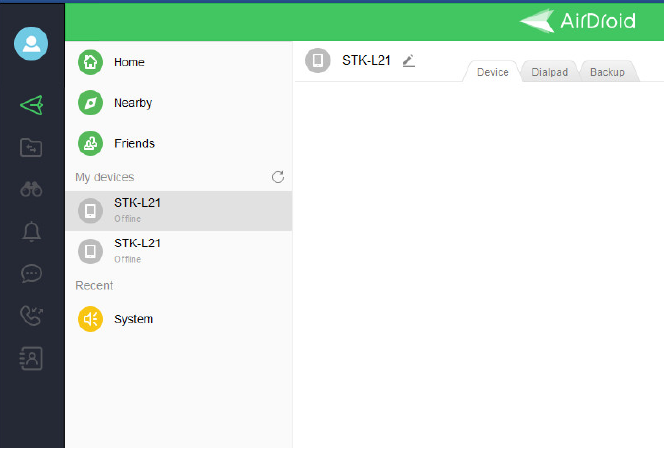
Figure 7. Screenshot of AirDroid App.